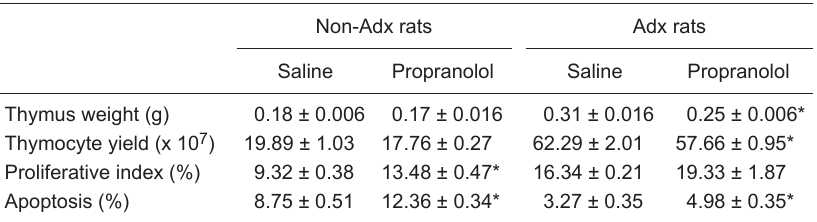
Table 1. Differential effect of 4-day propranolol treatment on thymus weight, thymocyte yield and proliferative index in adrenalectomized (Adx) and non-Adx adult rats compared to the corresponding saline-treated